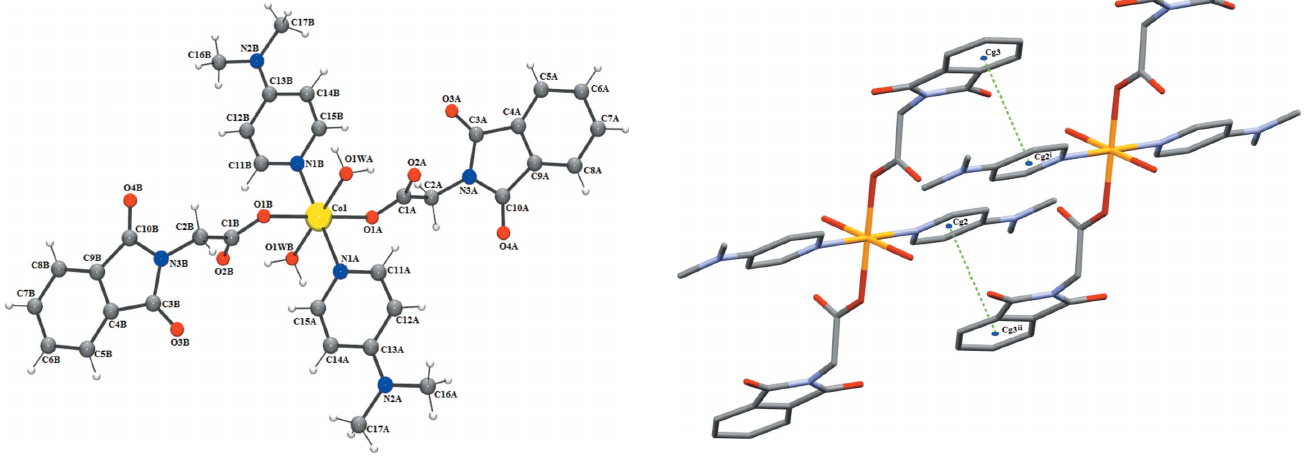
Figure 3 (cid:2) – (cid:2) interactions (dashed lines) between the 4-(dimethylamino)pyridine and benzene rings of N -phthaloylglycine in the title compound [symmetry codes: (i) = (cid:5) 1 + x , y , z ; (ii) = 1 + x , y , z ].